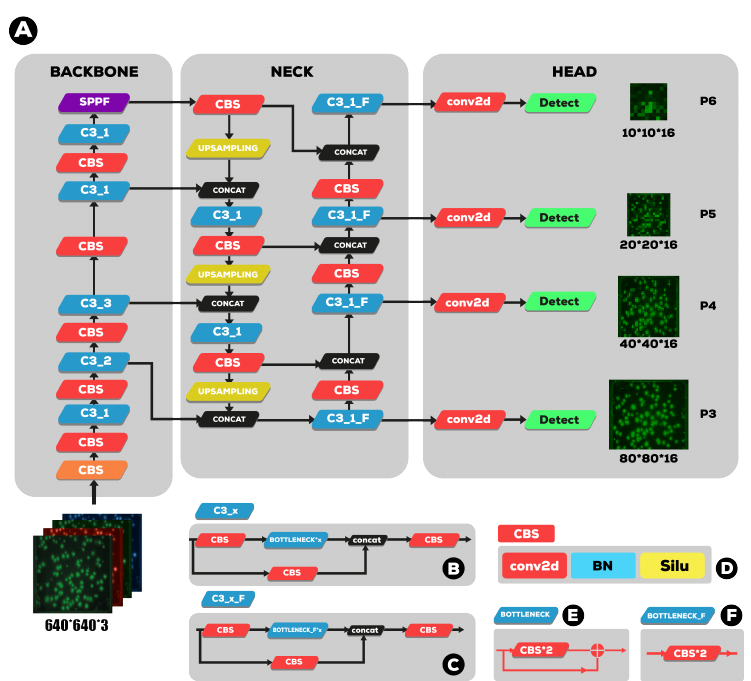
Figure 3. YOLOv5 version 6.1 ( A ): the overall architecture that consists of three main parts: the backbone, the neck, and the head modules. ( B , C ) two distinct types of CSP blocks (C3). In ( D ), a key block called CBS is defined, which consists of a Conv layer, a BN layer, and a SILU This CBS block is used in many other blocks ( E ) and two different botllneck blocks ( F